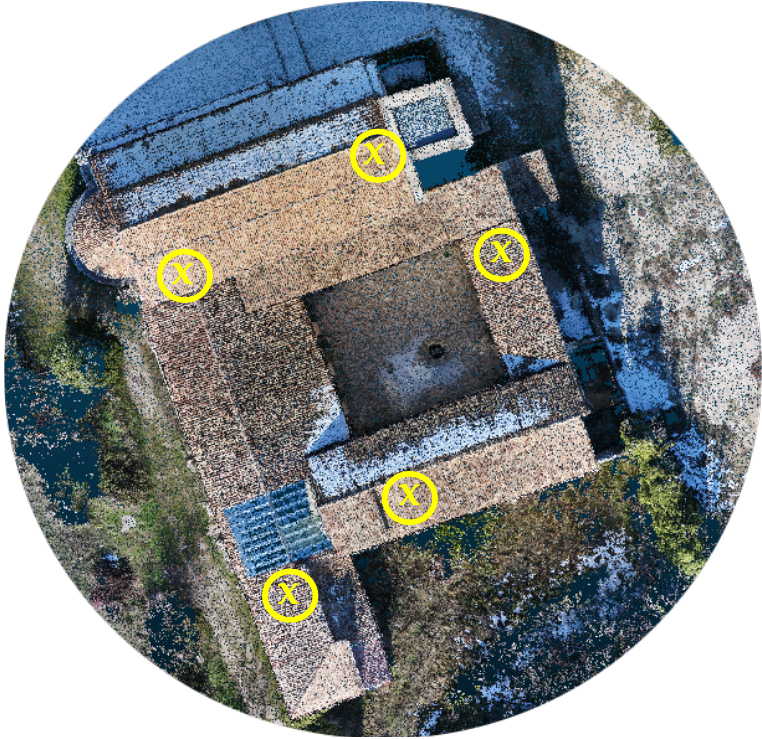
Figure 9. Position of markers adopted for the marker-based alignment.